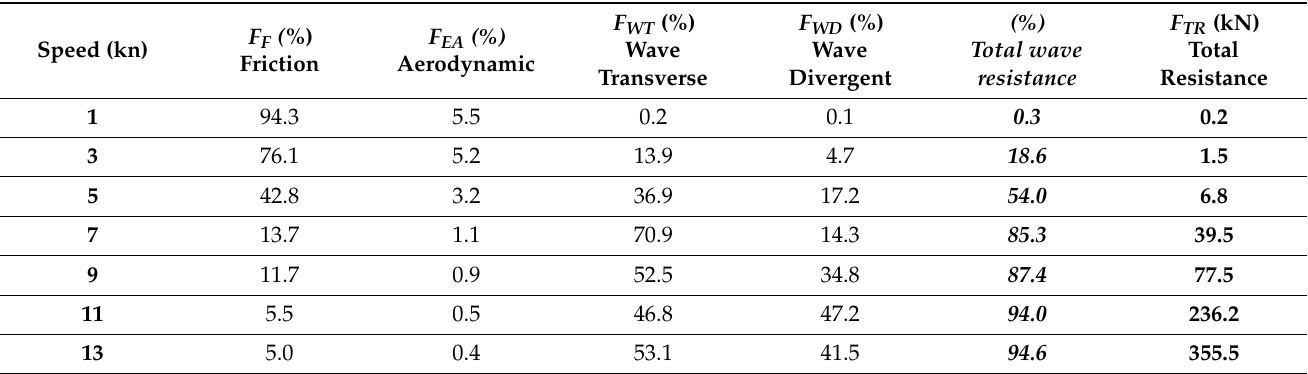
Table 1. Percentage of components of the total drag force FTR acting on a single tugboat at different speeds.